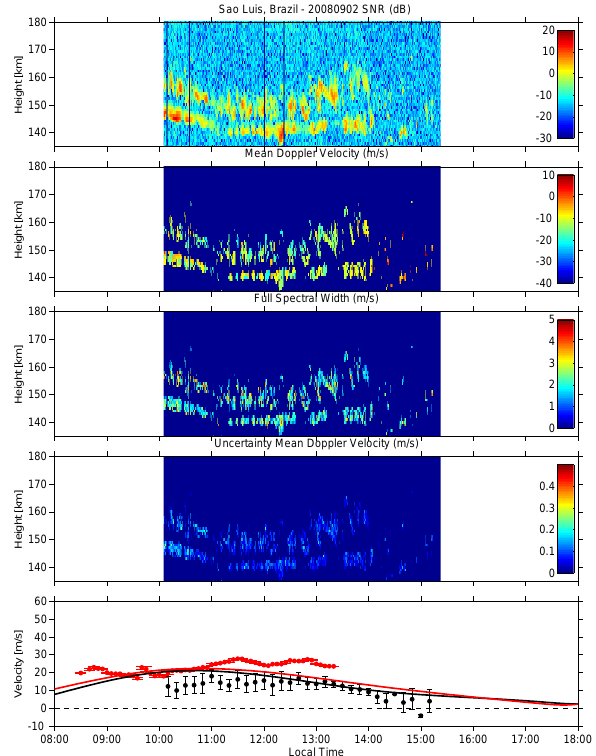
Fig. 5. Same as Fig. 2 but for 2 September 2008. The mean Doppler velocity of the 150km echoes measured by the Jicamarca radar is also show in (e) as red markers. The 3h Kp indices for this day are Fig. 5. Same as Figure 2 but for September 2, 2008. The mean Doppler velocity of the 150-km echoes measured by the Jicamarca radar is 1 − , 0 + , 1 − , 1, 1, 0 + , 0 + , also show in panel (e) as red markers. The 3-hour Kp indices for this day are: 1-, 0+, 1-,1, 1, 0+,0+,1.